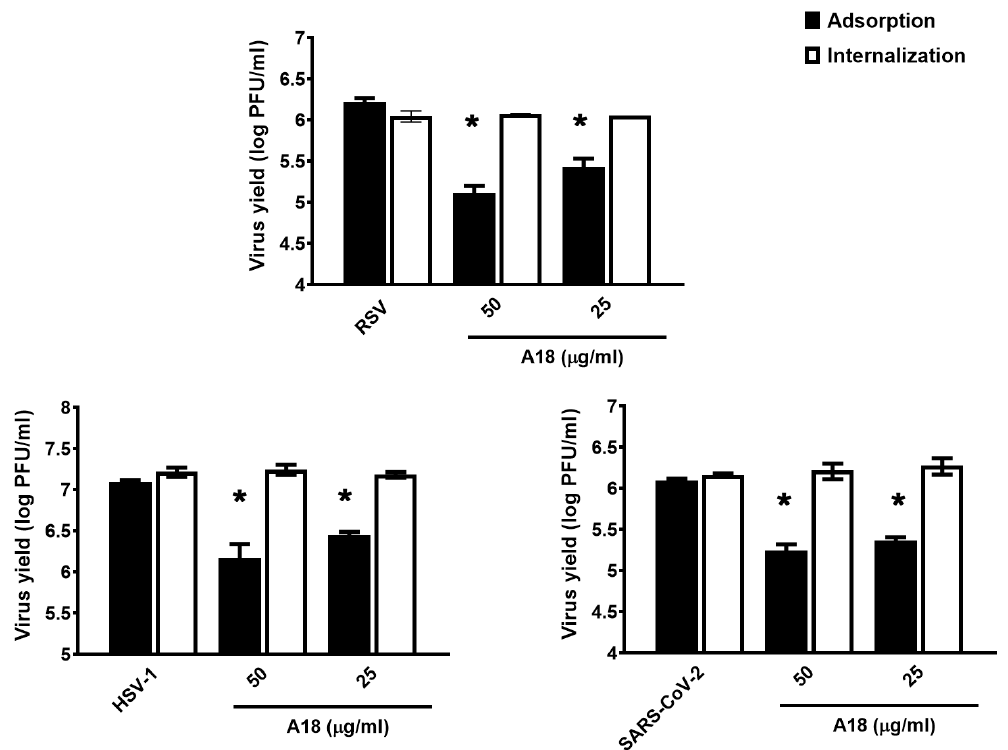
Figure 2. Influence of the duration of treatment with A18 on RSV infectivity. Virus adsorption: A549 cells were infected with RSV A2 (moi = 1), HCLE cells were infected with HSV-1 KOS (moi = 1), and calu-3 cells with SARS-CoV-2 (moi = 1) together with 25 µ g/mL of A18 and incubated for 1 h at 4 ◦ C. The inoculum was discarded, and cells were washed, supplemented with fresh medium, and further incubated for 24 h at 37 ◦ C. Virus yields were collected and titrated by plaque assay. Virus internalization: A549 cells were infected with RSV A2 (moi = 1), HCLE cells were infected with HSV-1 KOS (moi = 1), and calu-3 cells with SARS-CoV-2 (moi = 1) and incubated for 1 h at 4 ◦ C. The inoculum was discarded, and cells were washed and treated with 25 µ g/mL of A18 for 2 h at 37 ◦ C. Afterwards, cells were washed, and the non-internalized virus was inactivated with citrate buffer (pH 3) for 1 min. Cells were further incubated with fresh medium for 24 h at 37 ◦ C. Virus yields were collected and titrated by plaque assay. Data represent mean ± SD for n = 3 independent experiments, performed in duplicate. * Significantly different from CV ( p -value <